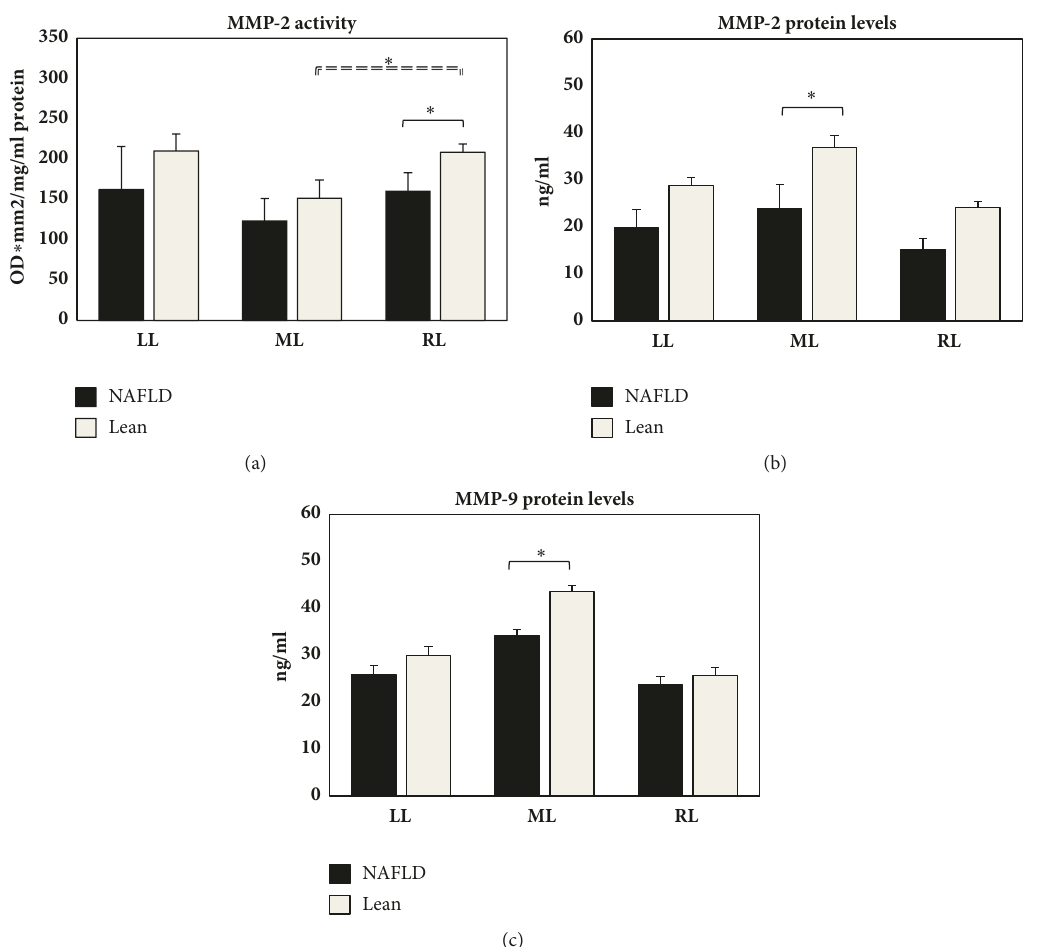
Figure 4: Hepatic content in MMP-2 activity (a) and MMP-2 and MMP-9 protein levels ((b) and (c)) obtained from LL, ML, and RL in NAFLD and Lean rats. MMP gelatinase activity is expressed as optical density (OD) for mm2, related to 1 mg/mL protein content. MMP content is expressed in ng/mL. Data are shown as mean values ± SE. ∗ p < 0.05.